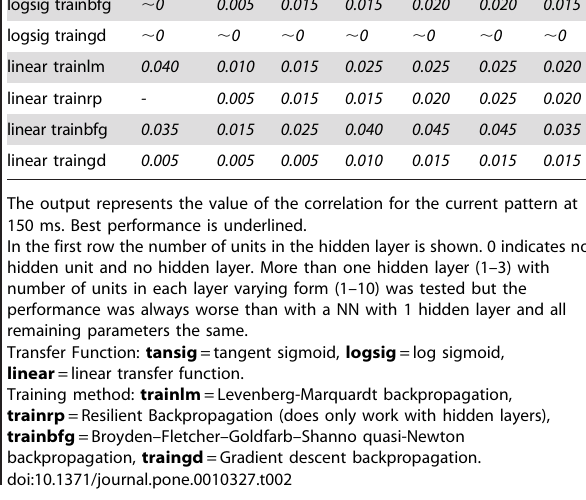
Figure S1 An example of the extracellular signal recorded with the 16 channel single shank electrode. The shaded region indicates the 250ms stimulus time interval. Figure S2 An 2 MUA example of the population decoding. A: The transition that will be studied (top). The 16 6 16 tile pattern is made by repeating a 2 6 2 tile image 8 6 8 times as indicated by the green grid (bottom). B: The target pattern (left) and its average (across all 8 6 8 regions) 2 6 2 tile image (right). The difference between the target pattern and the previous pattern and its average 2 6 2 tile image (bottom). C: The receptive fields of two MUAs (top) and the average (across all 8 6 8 regions) 2 6 2 tile image for the corresponding receptive field (bottom). D: Which of the two patterns displayed in B are most similar to the receptive field of multiunits MUA 1 and MUA 2 shown in C? The degree of similarity is extracted by multiplying the pattern with the receptive field. This is done for all 4 combinations; Target* MUA 1 , Difference* MUA 1 , Target* MUA 2 and Difference* MUA 2 . The target pattern is preferred by MUA 2 and the difference pattern is preferred by MUA 1 . E: The same conclusion as in D but on the basis of the firing rate of MUA 1 and MUA 2 in response to the target and difference patterns when the respective pattern is preceded by a gray screen, i.e., the dictionary paradigm. F: The firing rate for MUA 1 and MUA 2 in response to the pattern transition shown in A. G: The decoded pattern based on the firing rate in F, i.e., the relay paradigm. Figure S3 Comparison of four different decoding techniques. A: The correlation weighted average (see methods). B: The decoded pattern is the pattern that corresponds to the maximal correlation (see Methods). C: Back propagation neural network with optimal parameters. See Table 2. D: Multi-Class, Support Vector Machine Based Decoding. See Table 1. Figure S4 Supplementary figure 4. Receptive fields from all 5 animals. To the right of each receptive field we have for illustration purpose depicted the mapping of that receptive field to the 2 6 2 tiled pattern. This is done by averaging all 8 6 8 (denoted by the green lines) 2 6 2 tiles of the receptive field. This averaging is motivated by the fact that the 2 6 2 stimulus pattern is